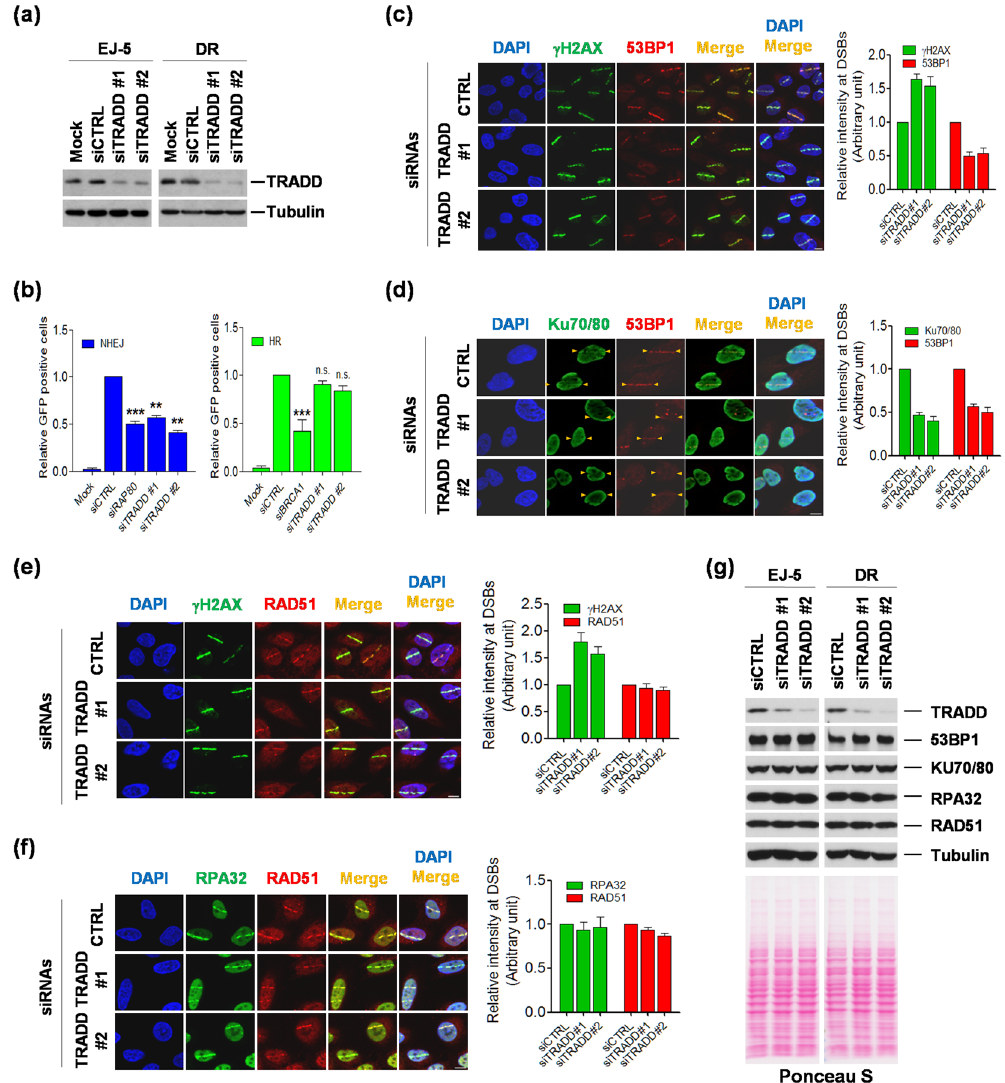
Figure 3. TRADD is required for non-homologous end-joining repair. ( a ) Knockdown efficacy for TRADD in DNA repair reporter cell lines EJ5 and DR. ( b ) After 48 hours transfection with TRADD, RPA80, or BRCA1 targeting siRNAs into reporter cell lines, each siRNA was again cotransfected with an I- SceI endonuclease construct. After 72 hours, GFP positive cells were analyzed with a flow cytometer (FACScan). ** P < 0.01; *** P < 0.001; n.s., not significant (ANOVA). ( c , d ) After 1 hour with laser microirradiation, endogenous NHEJ repair factors were stained with each antibody at DNA break sites: 53BP1 ( c ); Ku70/80 and 53BP1 ( d ). Scale bars, 10 μ m. ( e , f ) Endogenous HR repair factors were stained as described in c . RAD51 ( e ); RPA32 and RAD51 ( f ). γ H2AX was used as a DNA damage marker at DNA break sites in ( c ) and ( e ). Scale bars, 10 μ m. ( g ) The protein levels of repair factors in TRADD depletion. EJ-5 or DR cells were transfected with TRADD siRNAs (#1 or #2) or control siRNA. The levels of repair factors were detected by using target antibody, respectively. Total protein levels were verified with Ponceus S staining and tubulin antibody as a loading